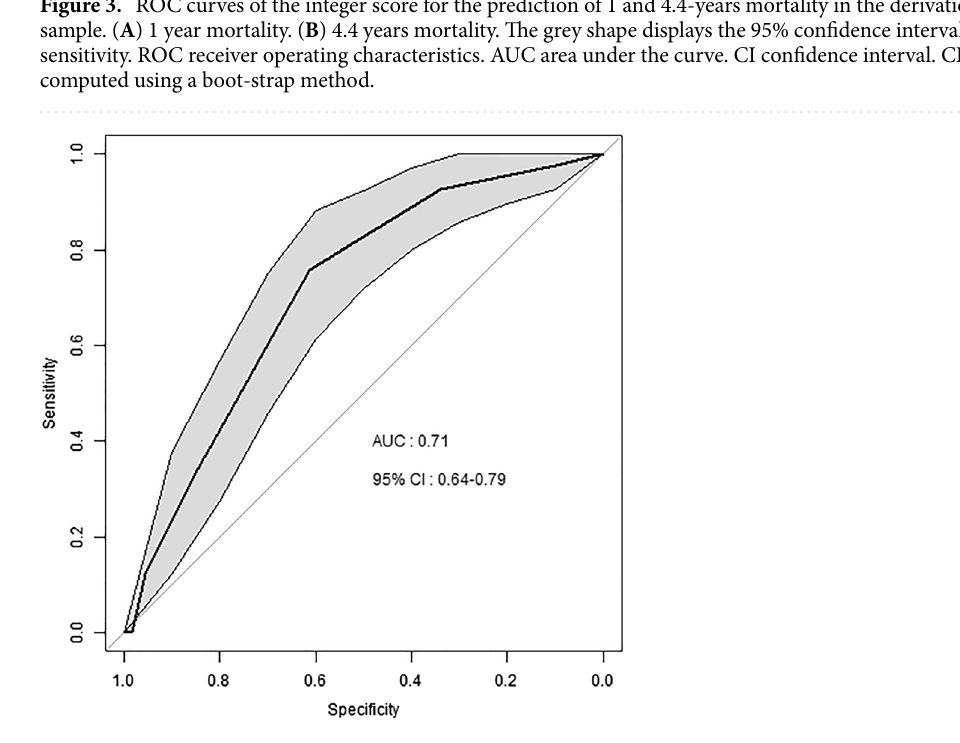
Figure 4. ROC curves of the integer score for the prediction of 1 and 4.4-years mortality in the validation sample. The grey shape displays the 95% confidence interval of sensitivity. ROC receiver operating characteristics. AUC area under the curve. CI confidence interval. CI were computed using a boot-strap